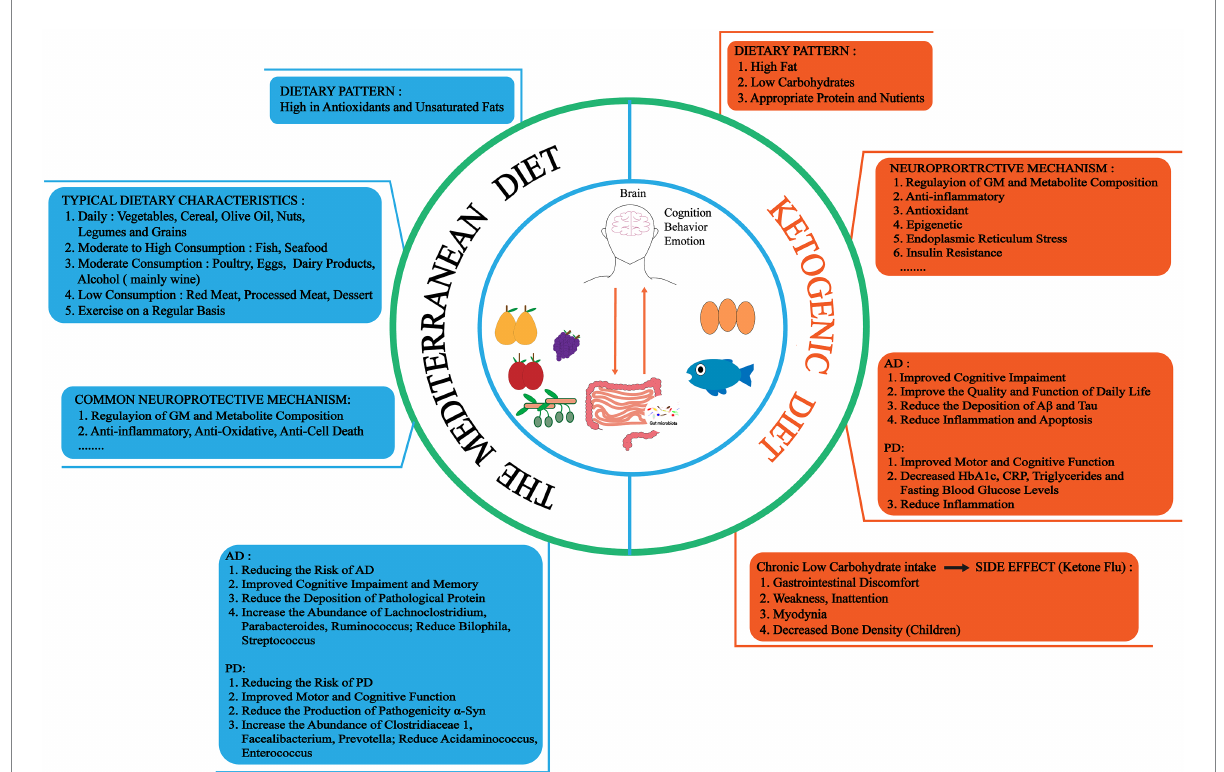
FIGURE 3 There are two dietary treatments for NDs, the Mediterranean diet (MedD) and the ketogenic diet (KD). MedD is a dietary pattern rich in antioxidants and unsaturated fatty acids, which has neuroprotective effects such as regulating GM and metabolite composition, anti-inflammatory, antioxidant and reduce pathological proteins. And there are different intake strategies for different foods. KD is a high fat, low carbohydrate, appropriate protein and nutrients dietary pattern. Neuroprotective mechanisms may involve regulation of GM and metabolite composition, anti-inflammatory, antioxidant, and epigenetic. However, long-term low carbon water intake can cause certain side effects, such as gastrointestinal, weakness, inattention, myodynia and decreased bone density. HbA1c, hemoglobin A1C. CRP, C-reactive